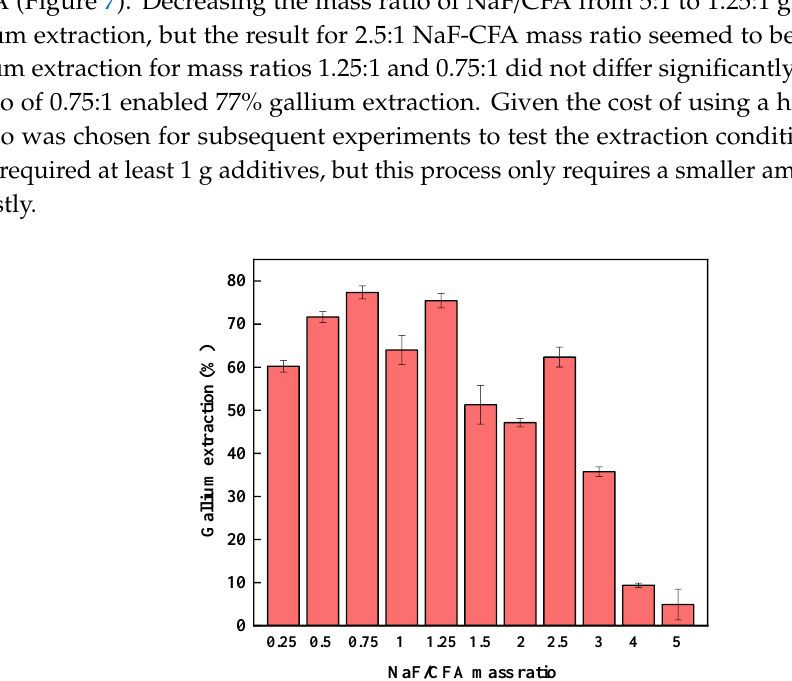
Figure 7. Influence of the NaF / CFA mass ratio on gallium extraction (roasting temperature of 800 ◦ C, roasting time of 10 min, leaching temperature of 120 ◦ C, leaching time of 2 h, and HNO 3 concentration of 2 mol/L).